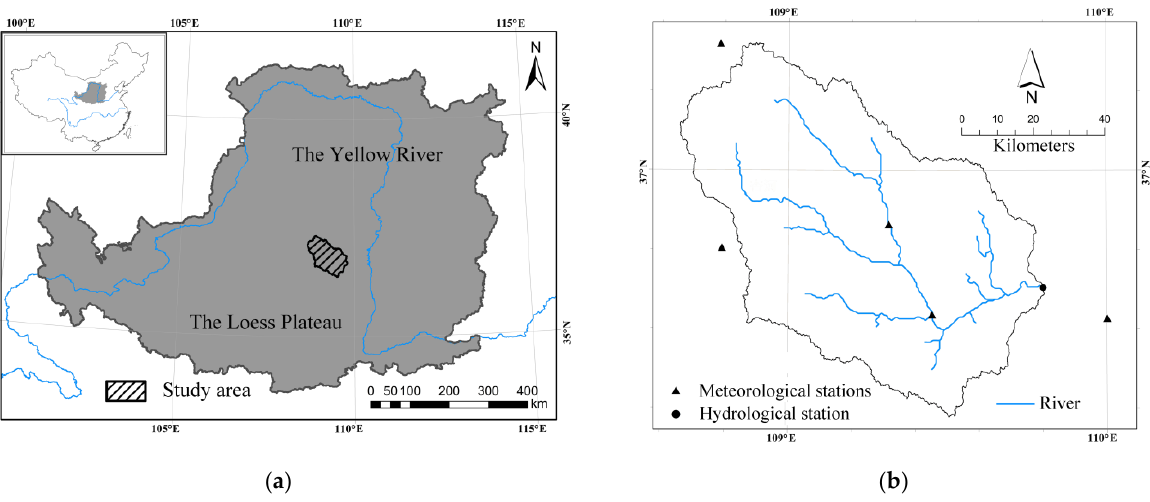
Figure 1. Location of the study area: ( a ) location of Yanhe River Basin on the Loess Plateau, ( b ) distribution of hydrological and weather stations.